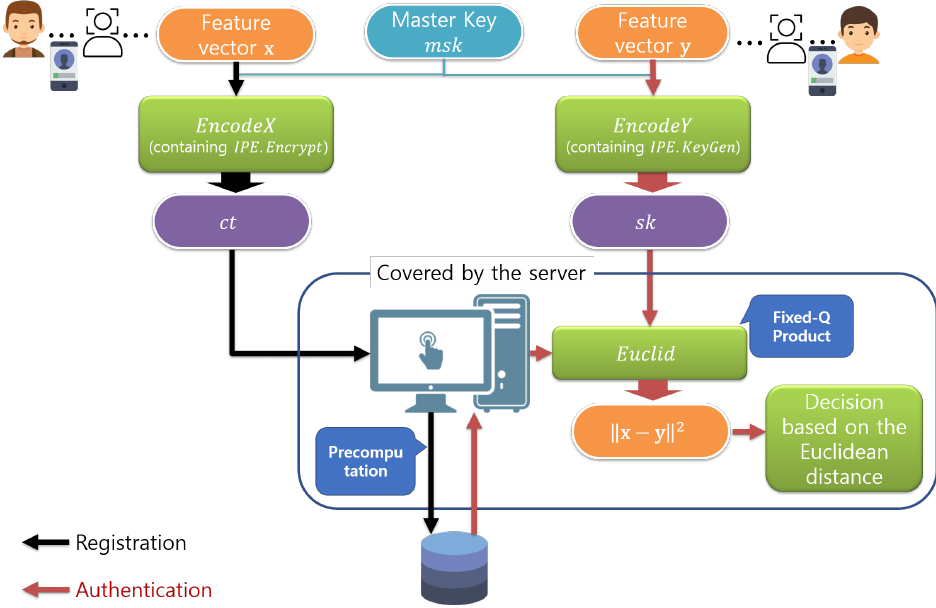
Figure 5. Simple facial verification system that uses ∏ IPE with the proposed